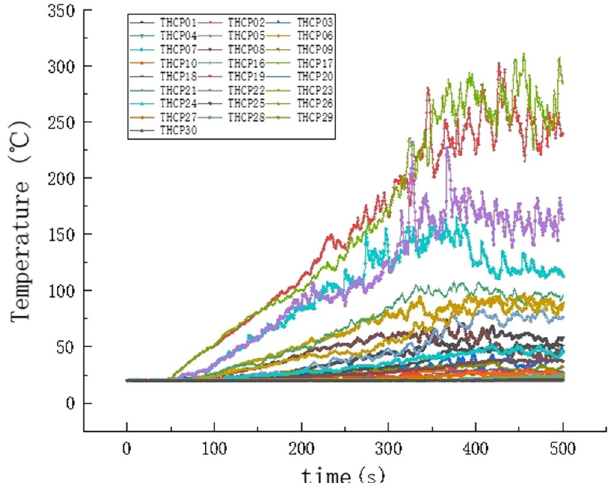
Figure 7. Temperature curve.